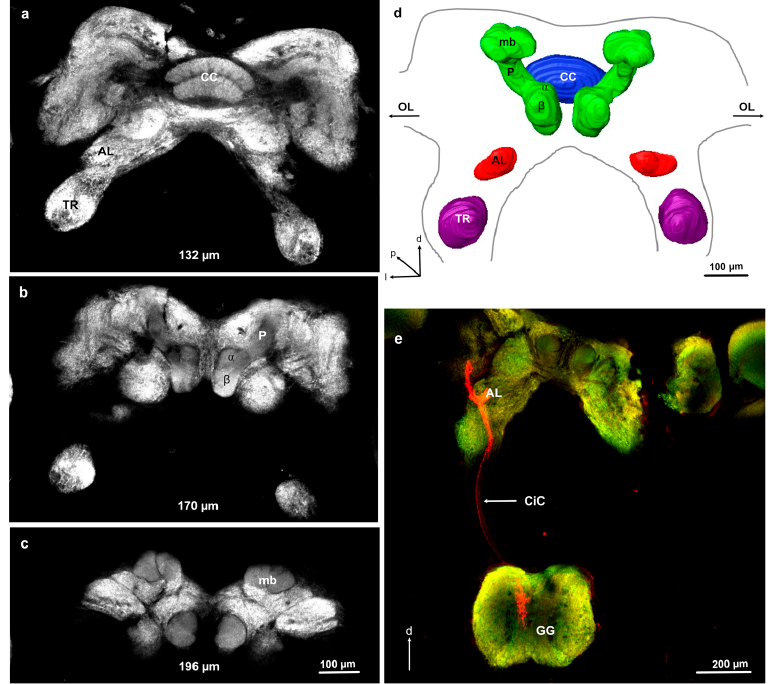
Figure 2 . General brain structure and antennal projections in Libellula depressa nymph (F3 instar). ( a – c ) Frontal optical sections through an anti-synapsin-stained F3 brain at different depths indicated below each image from anterior to posterior. ( d ) 3D reconstruction of the main brain neuropils. ( e ) Maximum z-projection over 38 μ m of confocal stack images of antennal axons targeting the antennal lobe (AL) and the gnathal ganglion (GG), illustrating the large distance between brain and GG in nymphs. α alpha lobe of the mushroom body; β beta lobe of the mushroom body; CC central complex; CiC circum-esophageal connective, d dorsal, l lateral; mb posterior part of mushroom bodies, OL arrows indicate where the optic lobes are attached; p posterior; P peduncle of the mushroom body; TR tritocerebrum. Microruby stained axons in red and background staining with the anti-synapsin antibody in green.